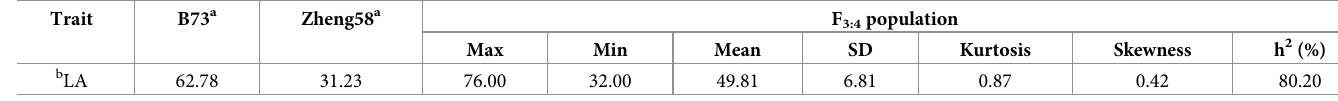
Table 1. Descriptive statistical analysis of phenotypic values of leaf angle in parents and F 3:4 population. Trait B73